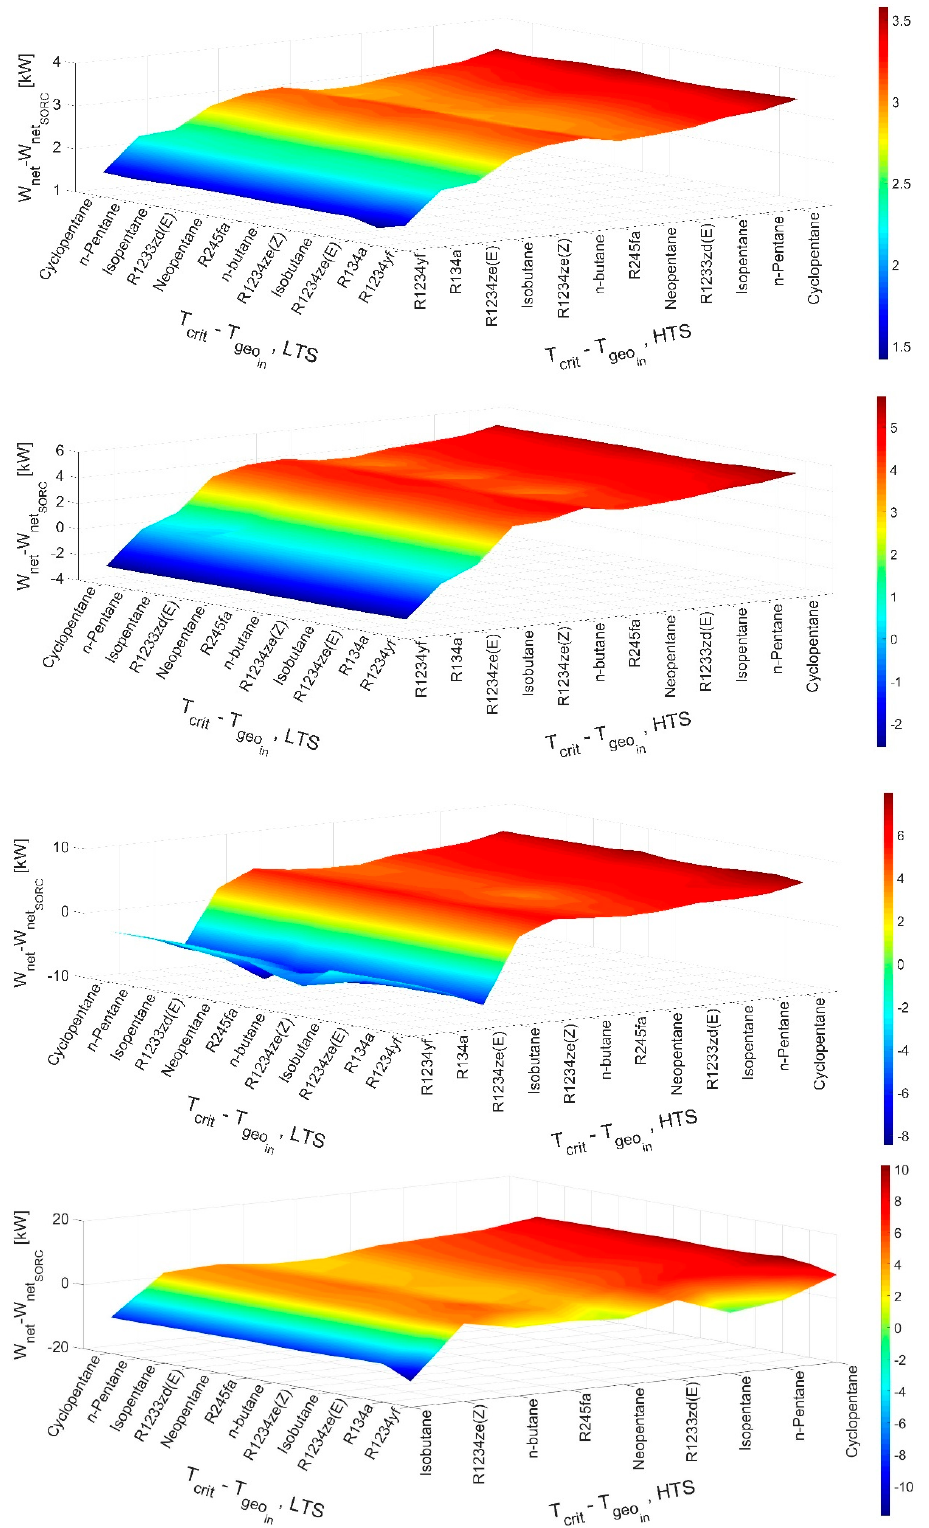
Figure 7. Net power values of the DS parHTSLTPH ORC configuration as compared with the SORC configuration for the corresponding working fluids in the HTS.